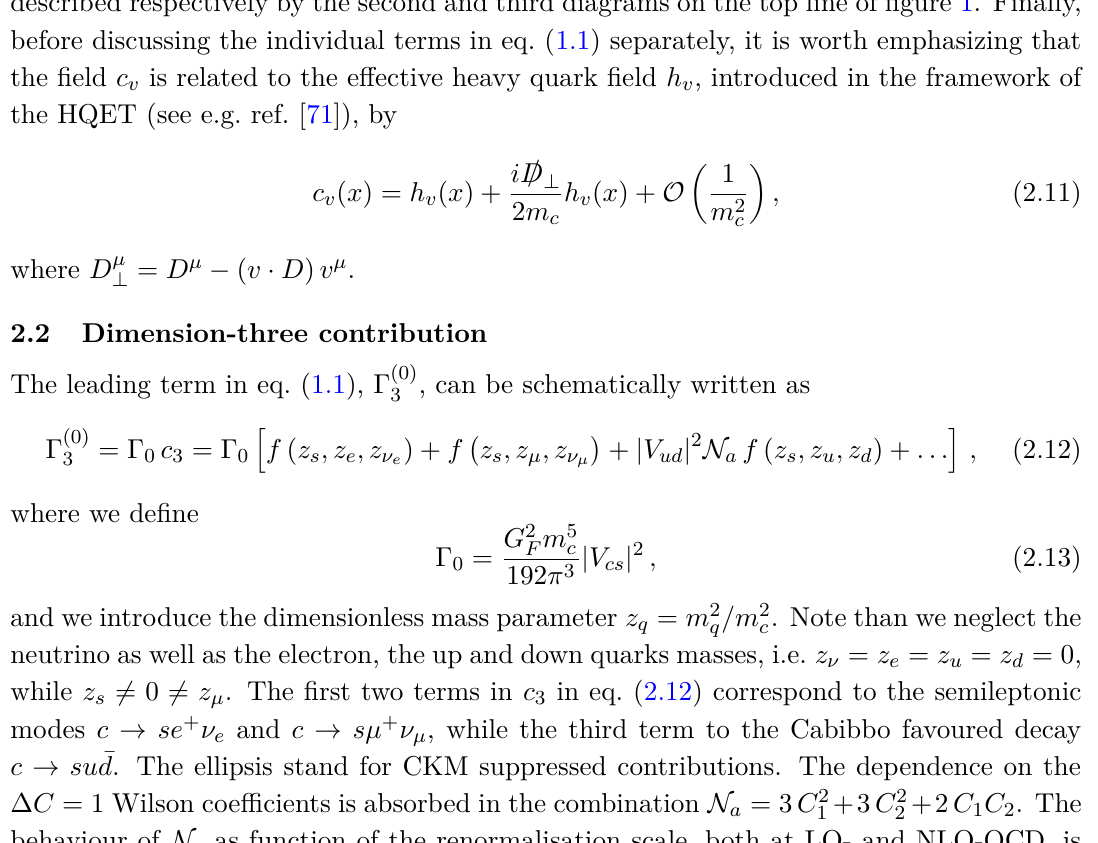
Figure 1 . The diagrams describing contributions to the HQE in eq. (1.1). The crossed circles denote the ∆ C = 1 operators Q of the effective Hamiltonian while the squares denote the local ∆ C = 0 i operators O and ˜ O . The two-loop and the phase space enhanced one-loop diagrams correspond i i respectively to the two-quark operators O and to the four-quark operators ˜ O in the HQE. i i corresponding to the limit m → ∞ , represents the decay of a free c -quark, while power c corrections due to the interaction of the heavy quark with soft gluons and quarks are described respectively by the second and third diagrams on the top line of figure 1.